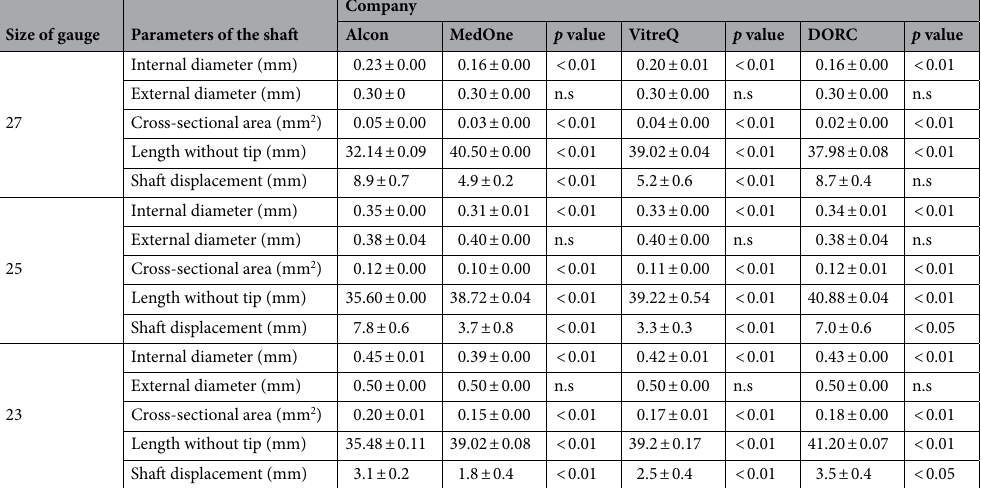
Table 2. Basic shaft data of each backflush needle.